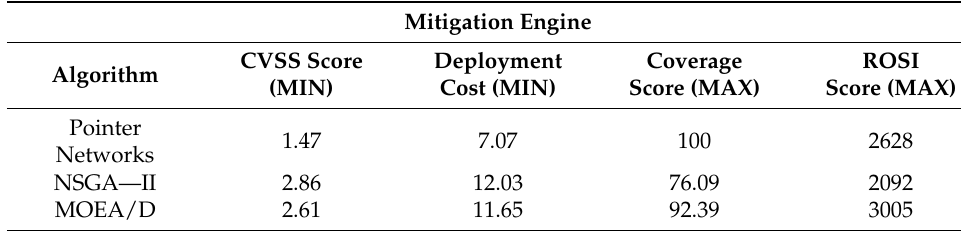
Table 3. Mitigation engine results.